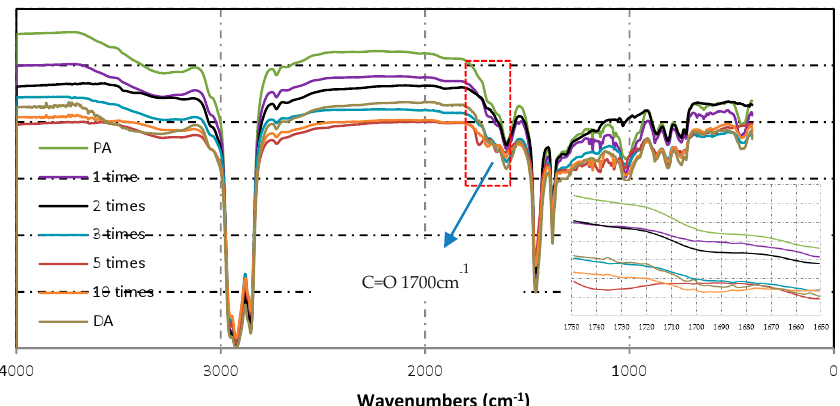
Figure 14. FTIR spectra of asphalt binders before and after induction heating.